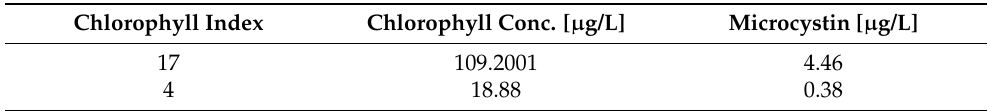
Table 3. Chlorophyll Index derived from HICO image, correlated with phycocyanin in situ measure- ments and correlated with microcystin